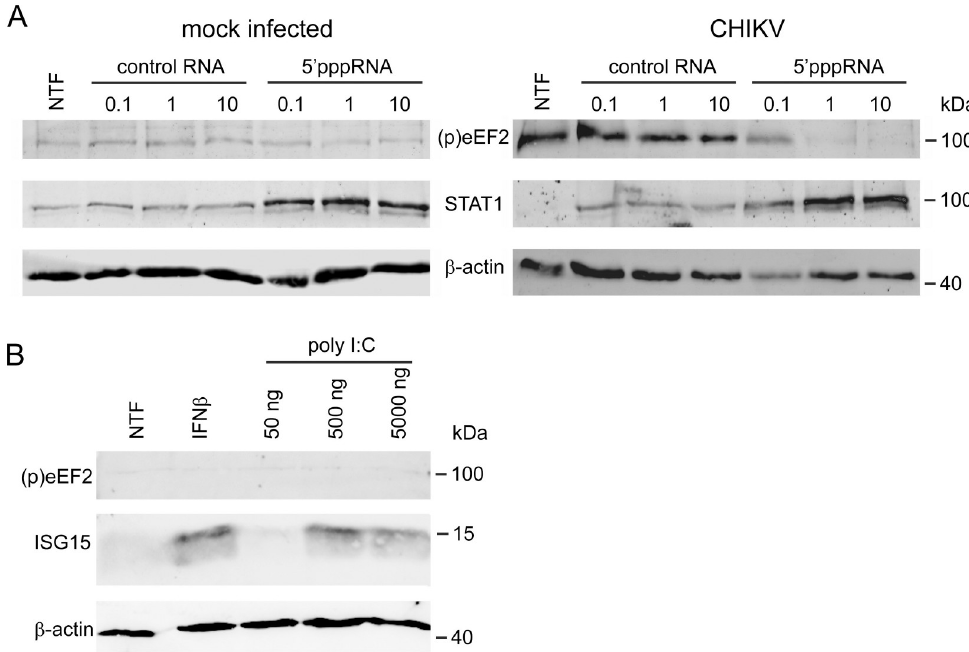
Fig 3. RIG-I & MDA5 activation does not trigger eEF2 phosphorylation. ( A ) MRC-5 cells were transfected with 0.1, 1, or 10 ng/ml 5’pppRNA or a control RNA 1 hour prior to infection with CHIKV-LS3-GFP (MOI 0.1) and non-transfected cells (NTF) were included as control. Protein lysates were harvested 24 h p.i. and STAT1 and (p)eEF2 (T56) were detected by WB analysis. ( B ) MRC-5 cells were transfected with 50, 500 or 5000 ng/ml poly I:C or treated with 200 U/ml IFN β and harvested at 24 h p.t. (p)eEF2 (T56) and ISG15 were detected by WB. Western blots are representative of two independent replicates.